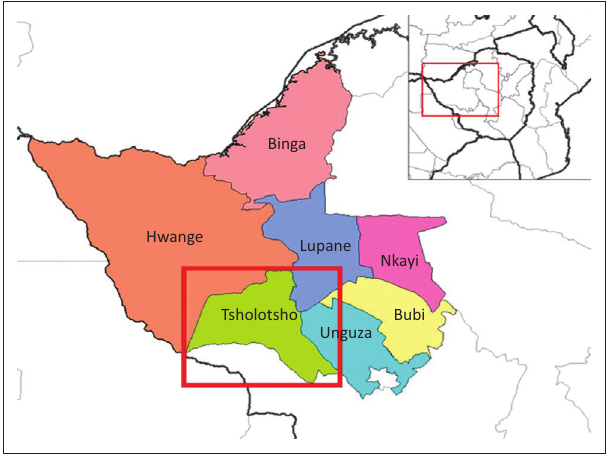
FIGURE 1: The map of Zimbabwe showing the location of Tsholotsho district in Matabeleland North province.